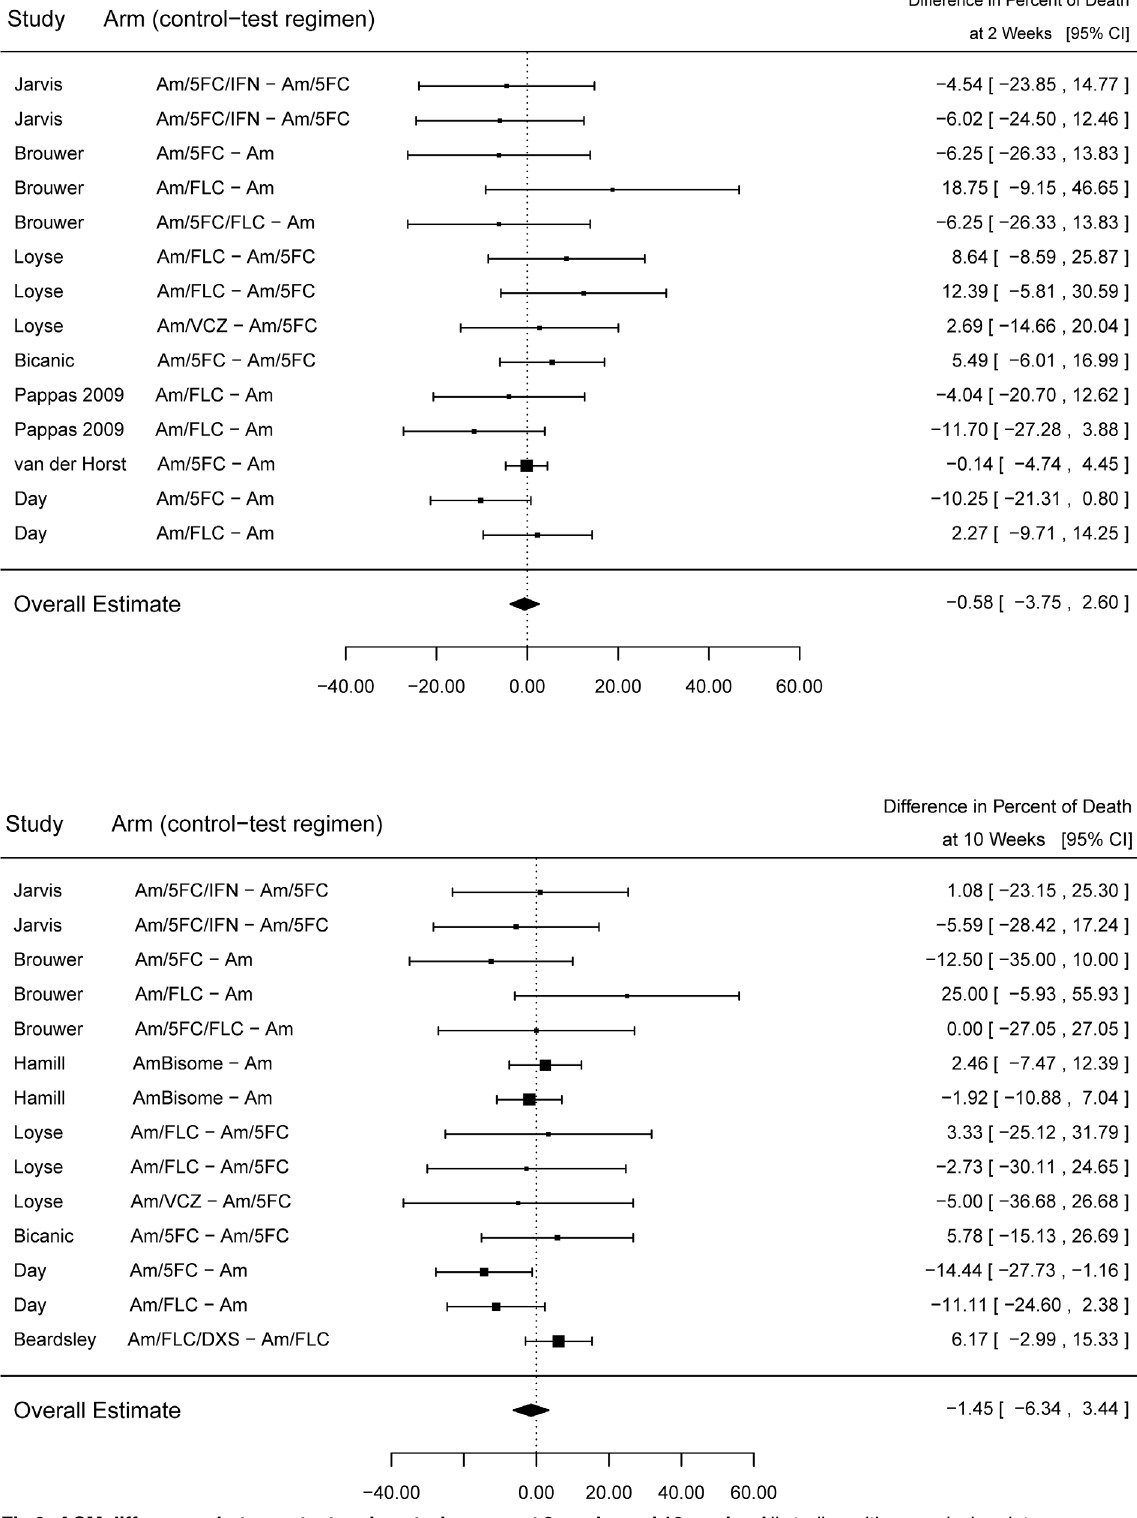
PLOS ONE | DOI:10.1371/journal.pone.0159727 August 4,